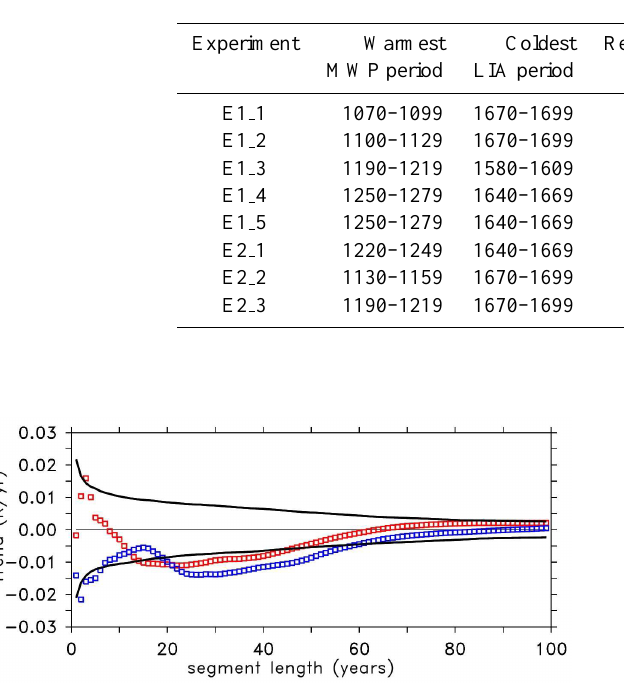
Table B1. Timing of occurrence of the warmest MWP and coldest LIA 30-year climatological periods in (left) the simulations, and (right) the reconstructions (Jansen et al., 2007).